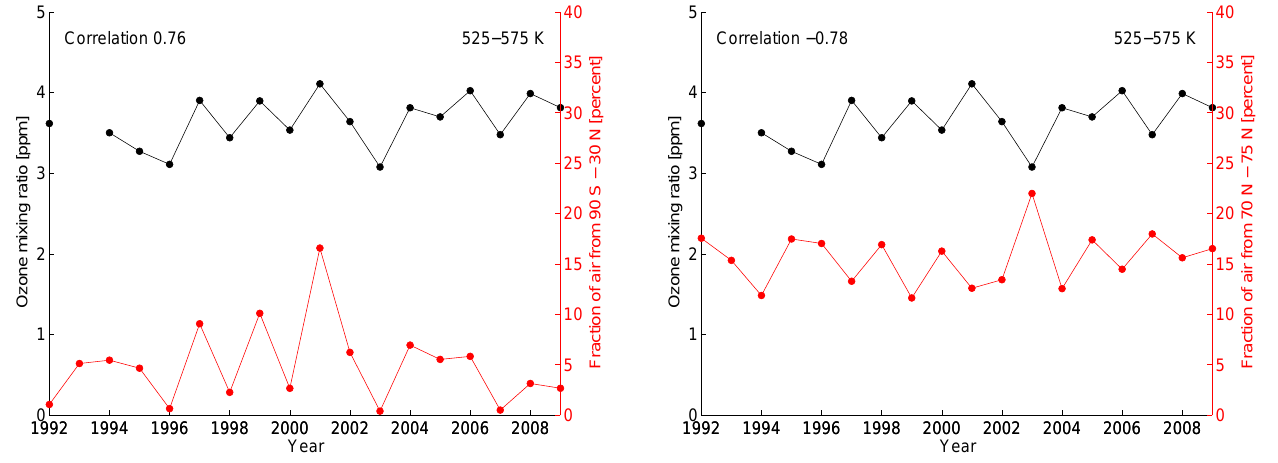
indicated at the vertical axis. The labels of the axis give the endpoints of the 50 K intervals. The time series of the origin tracer is the fraction of vortex air in early winter originating from the equivalent latitude intervals given at the horizontal axis on 1 September and averaged over the potential temper- ature intervals given at the vertical axis. E.g. the correlation coefficient of the two time series from Fig. 6 can be found in the first column and at the row between the labels 525